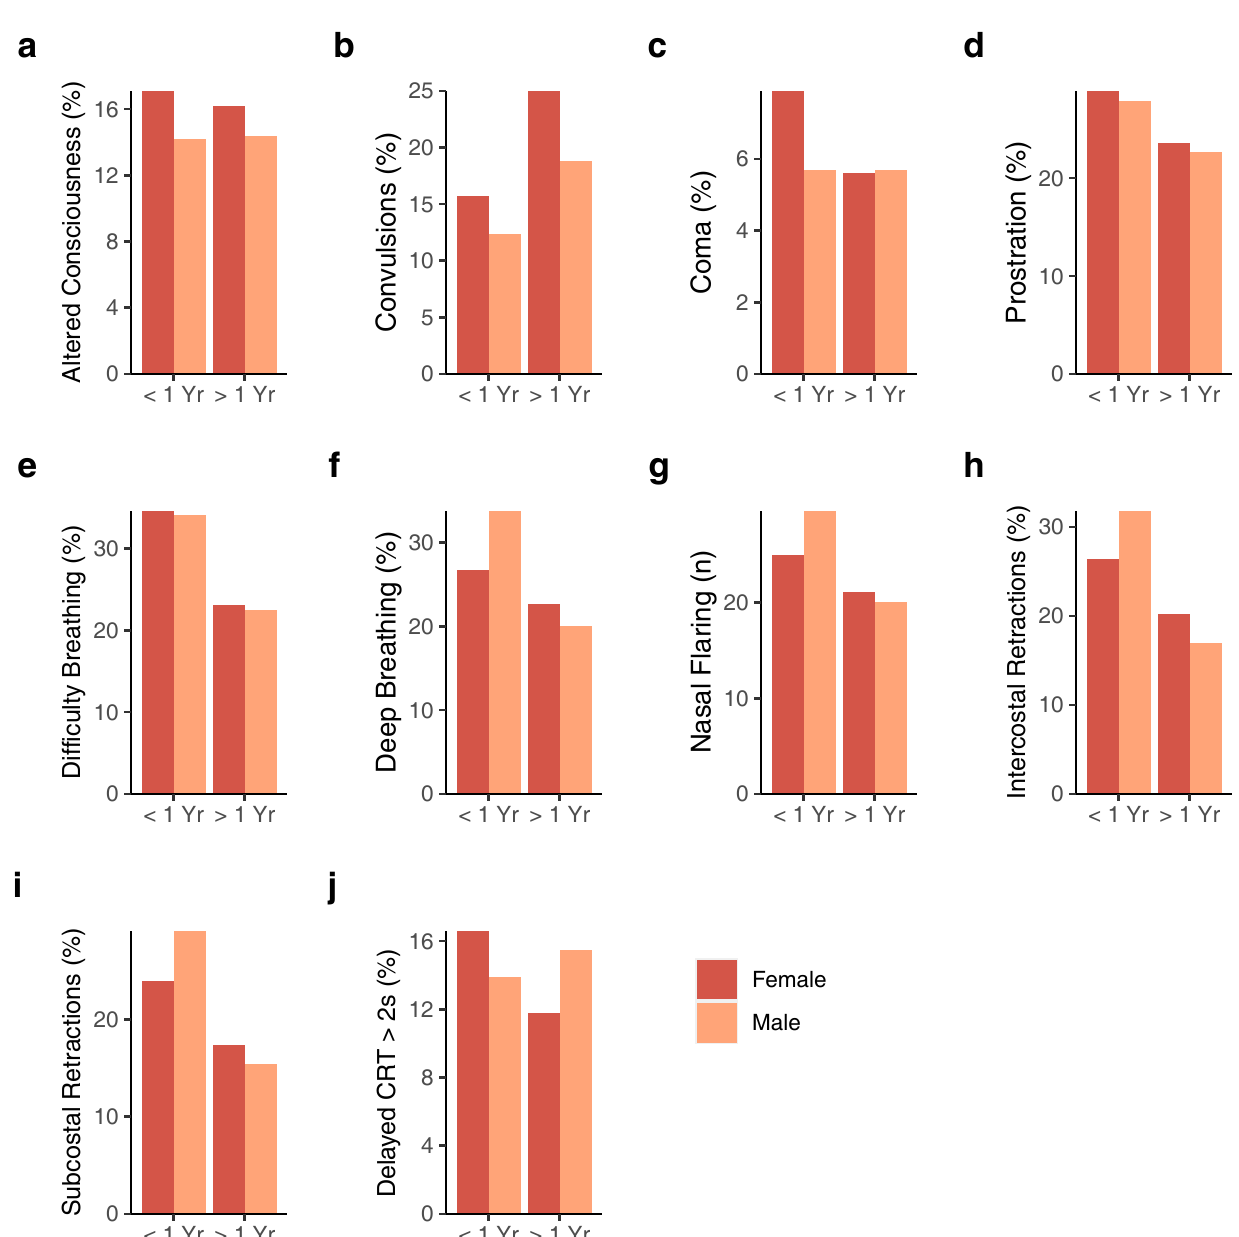
Fig 1. Percentage of participants displaying clinical parameters at presentation by sex in children � 1 year of age and in children between 1 year and 5 years of age (age range) including: (a) altered consciousness, (b) convulsions, (c) coma, (d) prostration (defined as inability to breastfeed if < 6 months, inability to sit up if > 6 months), (e) difficulty breathing, (f) deep breathing, (g) nasal flaring, (h) intercostal retractions, (i) subcostal retractions, and (j) delayed capillary refill time (CRT) > 2 seconds (2s). No comparisons were significant after controlling for multiple comparisons (P < 0.002 would be considered significant after Bonferroni correction,